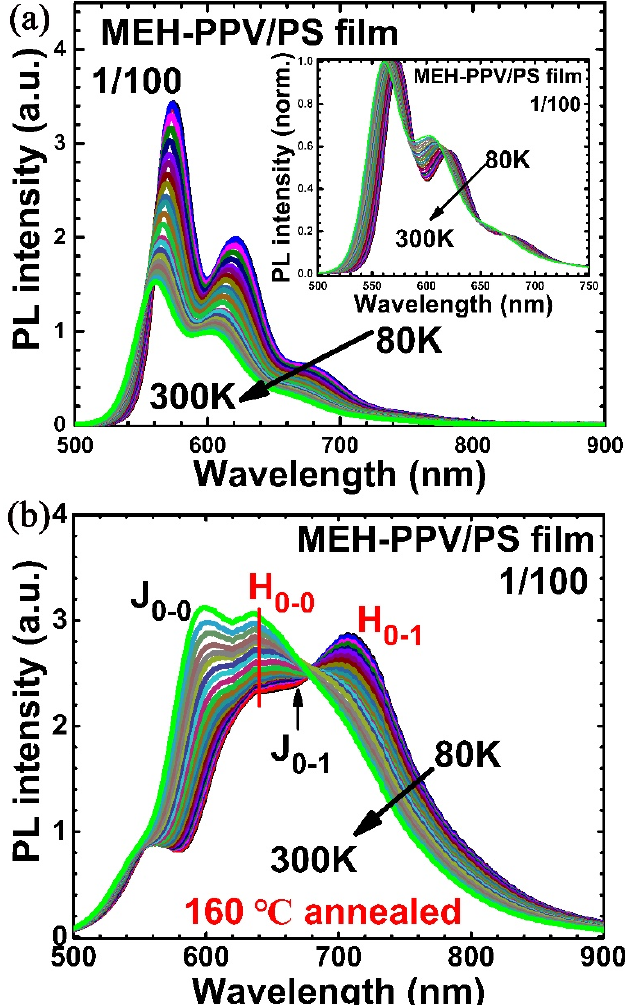
Figure 5. Temperature-dependent photoluminescence spectra of MEH-PPV/PS blend films with the weight ratio of 1/100. ( a ) As-cast film, ( b ) film annealed at 160 °C. Insert of ( a ) is its normalized spectra.